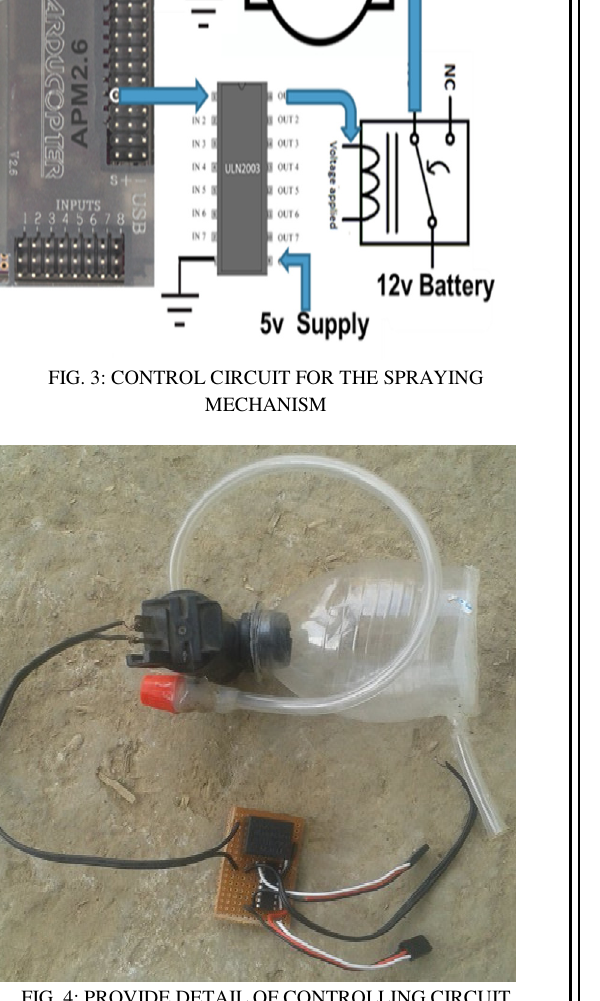
FIG. 4: PROVIDE DETAIL OF CONTROLLING CIRCUIT WITH SPRAYING TANK